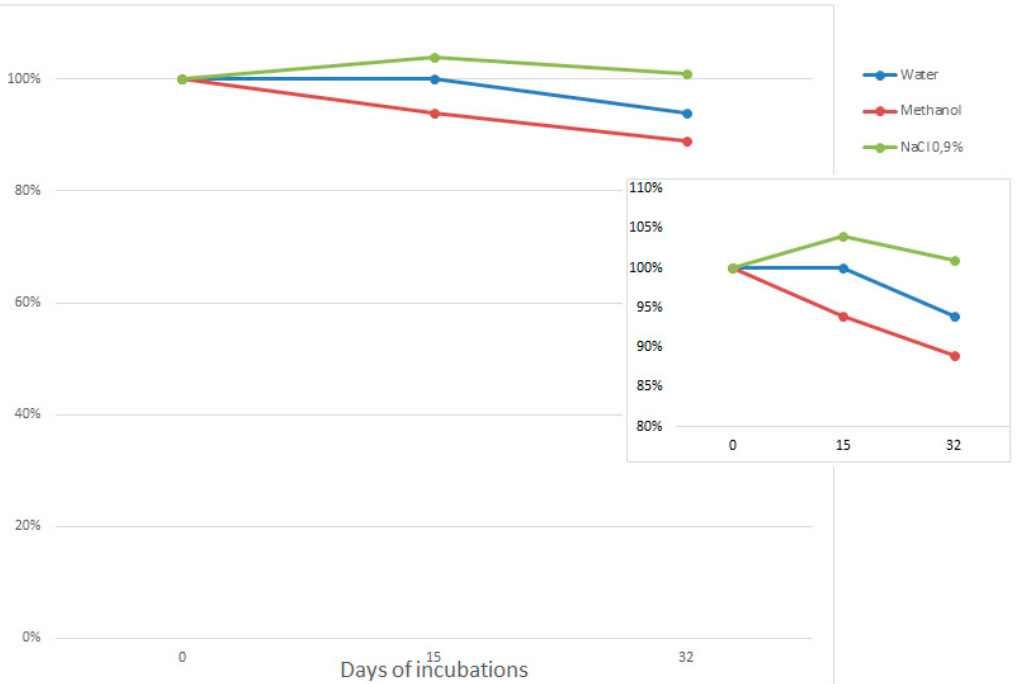
Table 1. Size and polydispersity index (PDI) comparison for both formulations of liposomes and